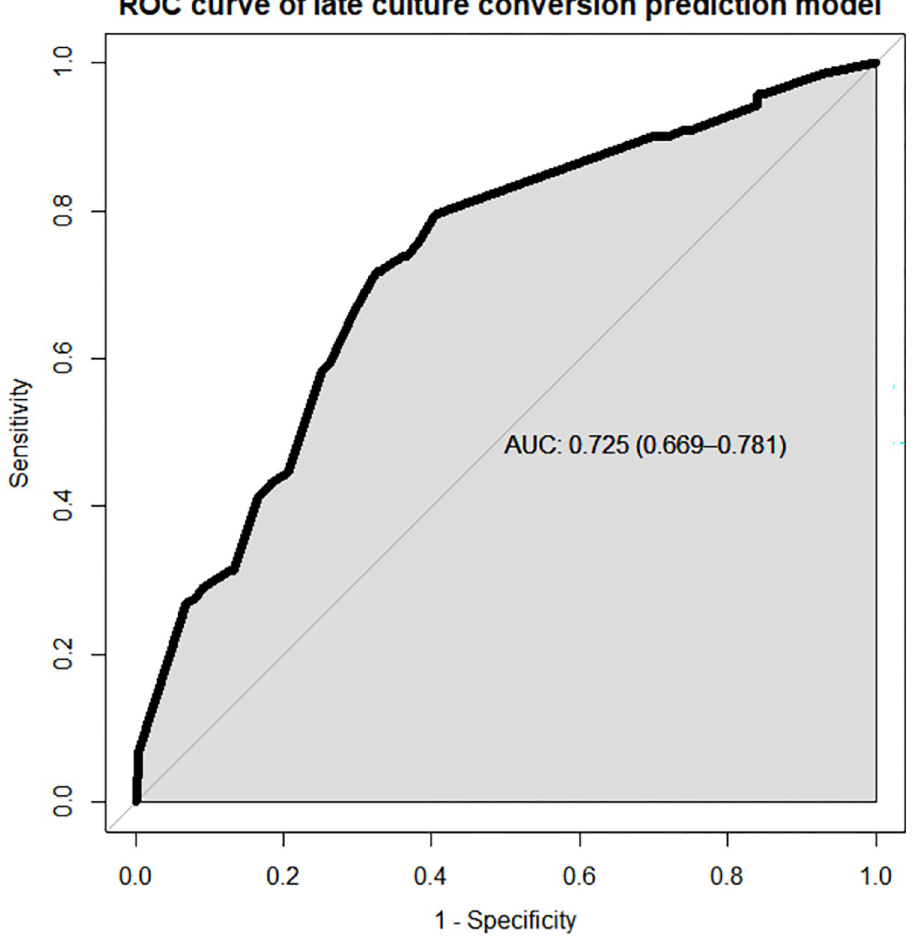
Fig 4. ROC curve of the risk prediction model for prediction of late culture conversion among MDR-TB patients in North West Ethiopia.